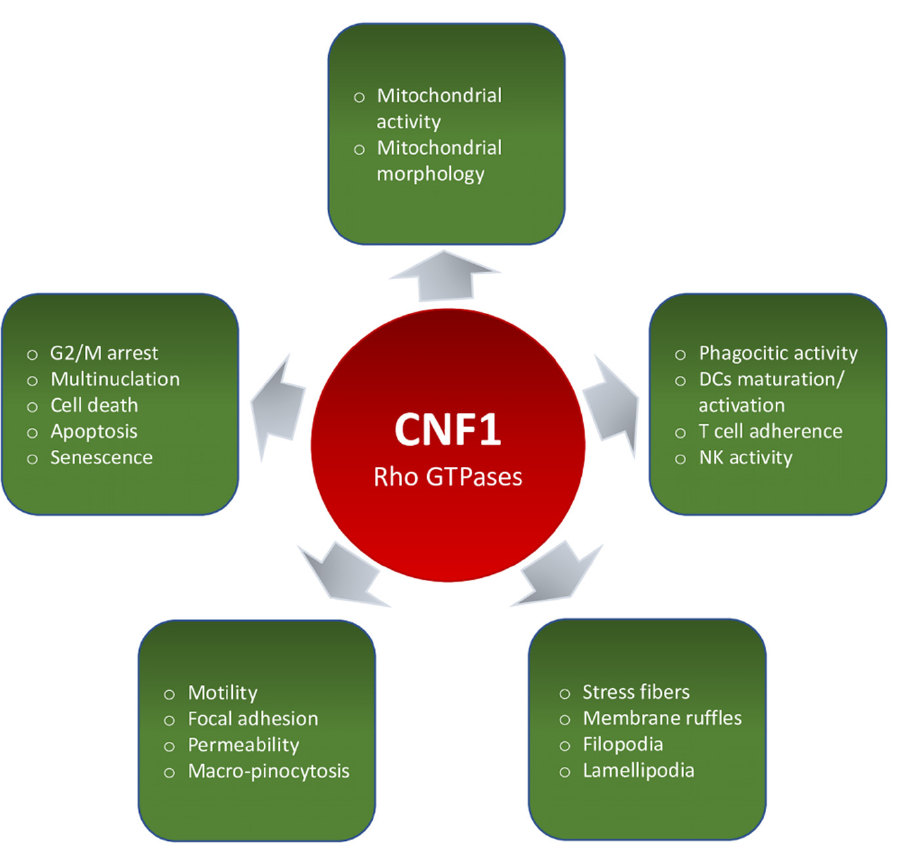
Figure 3. Graphical summary of the overall CNF1-induced effects reported in the literature.